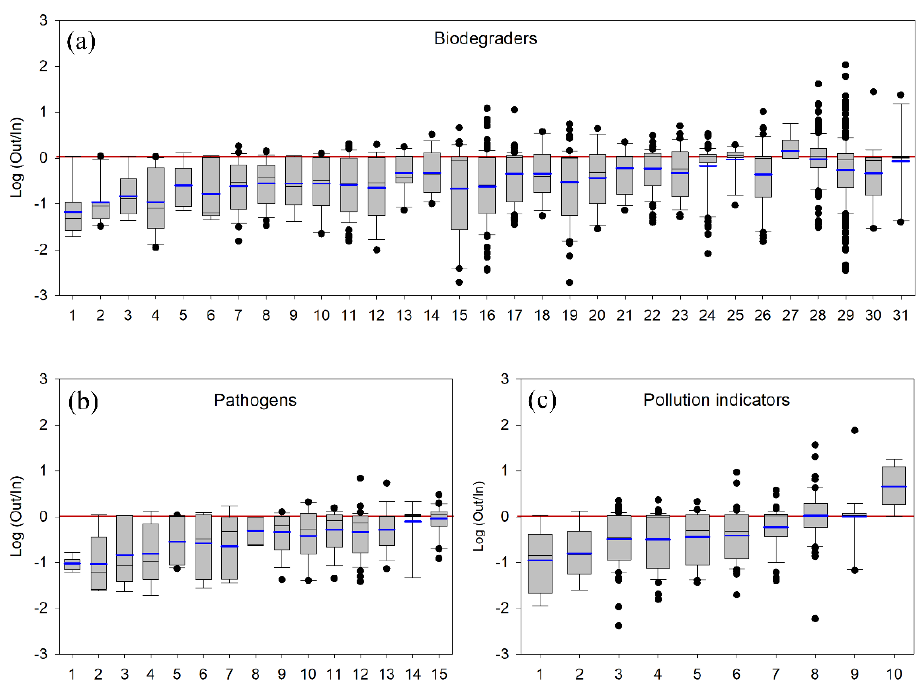
Figure 6. Log ratios of the different taxa (relative abundance > 1%) for which a significant change ( p < 0.05) in relative abundance was detected between upstream and downstream locations across all sampling sites and periods. Values above and below 0 indicate a higher abundance downstream and upstream, respectively. The box plots correspond to taxa in Table 2, with matching numbers for the biodegraders ( a ), pathogenic bacteria ( b ) and pollution indicators ( c ).